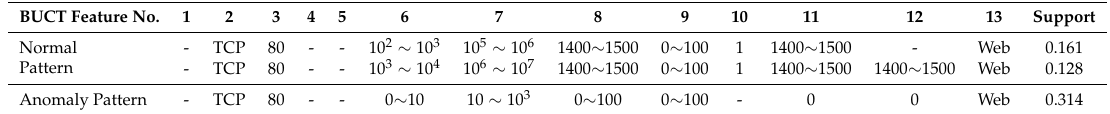
Table 6. Network patterns of BUCT.